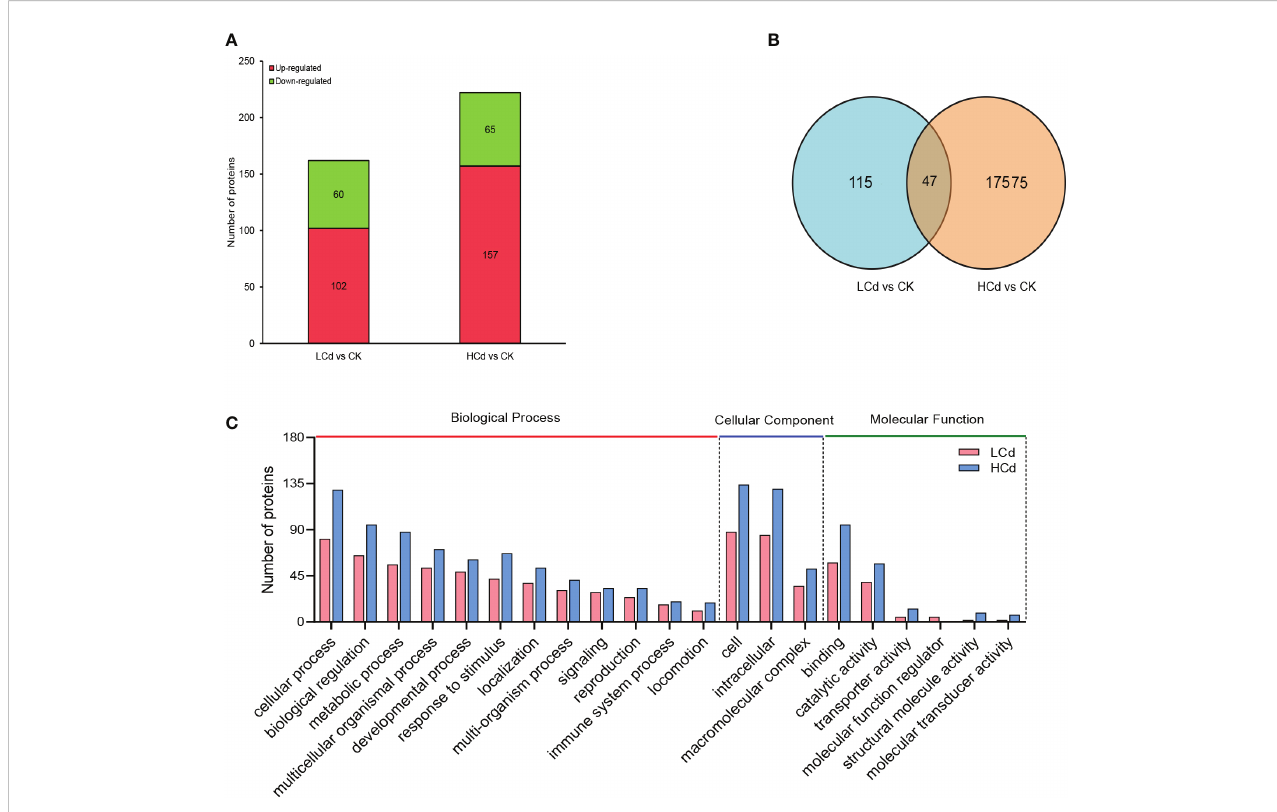
FIGURE 3 Quantitative proteomics data. (A) Signi fi cantly up- and down-regulated proteins in mussel gills of low- and high-dose groups compared with the control group. (B) Venn diagram showing the number of DEPs (differently expressed proteins) uniquely and commonly altered in the groups exposed to 100 and